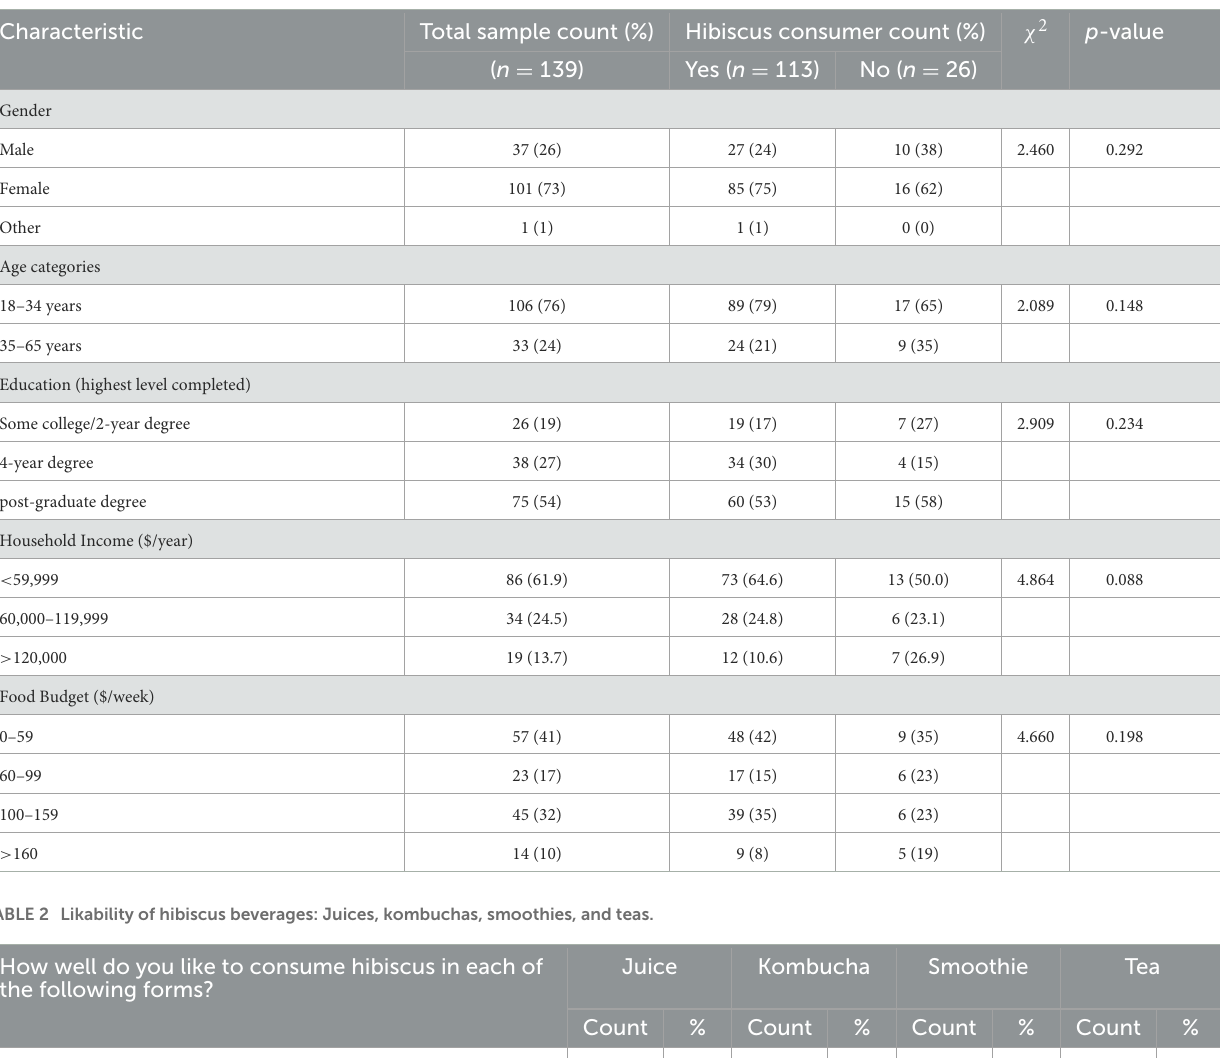
TABLE 1 Hibiscus consumption by participants’ demographic characteristics.